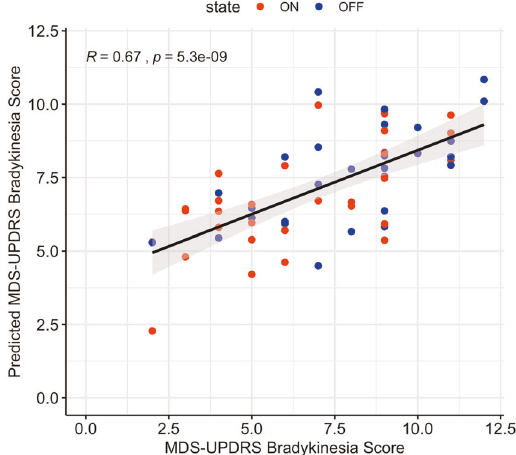
Fig. 4 Sensor-based assessment of hand bradykinesia and clinical rating. Agreement between predicted hand bradykinesia score and live rater ’ s hand bradykinesia score. Each point corresponds to one subject visit, solid line represents line of best fi t and shaded region represents the con fi dence interval. Hand bradykinesia score (range: 0 – 12) is a composite score derived by taking the sum of fi nger tapping (MDS-UPDRS 3.4), hand movement (MDS-UPDRS 3.5) and hand pronation-supination (MDS-UPDRS 3.6) scores.